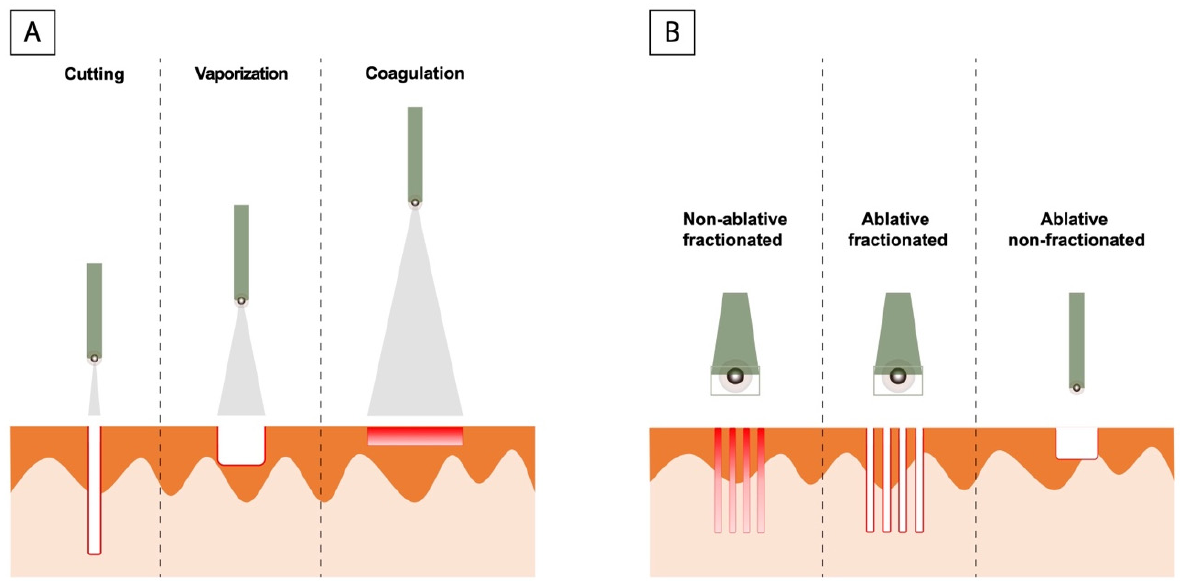
Figure 2. ( A ) Focused light with a very small beam of incidence on the skin (0.1–1 mm) causing pinpoint injury, which allows us to use it as a cutting system for cutting. Separating the laser handpiece from skin we produce a larger spot (2–5 mm), increasing the area of laser-tissue interaction, and thus vaporizes the tissues. Finally, a large spot size (4 mm) causes a drop in irradiance, resulting in non-ablative coagulation, which allow hemostasis of small bleeding vessels. ( B ) Types of CO 2 laser: Non fractionated laser acts on the entire treated area, however fractionated lasers treat only small columns of the treated skin, known as microthermal zones (MTZs). These MTZs can be non-ablative dermal injuries or both epidermal and dermal injuries in case of ablative fractionated laser.